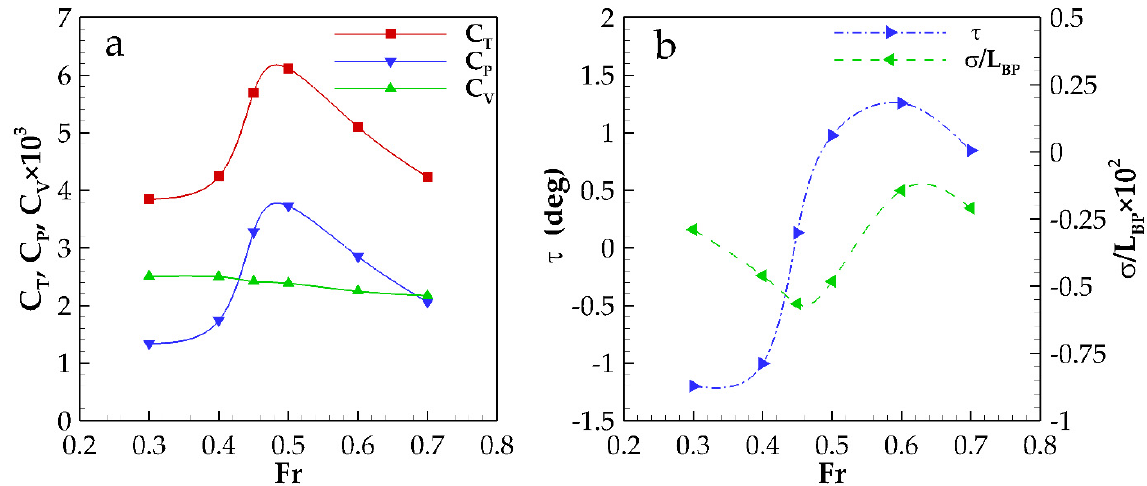
Figure 7. The resistance components ( a ) and motion characteristics ( b ) of the full-scale Double-M craft in calm water.